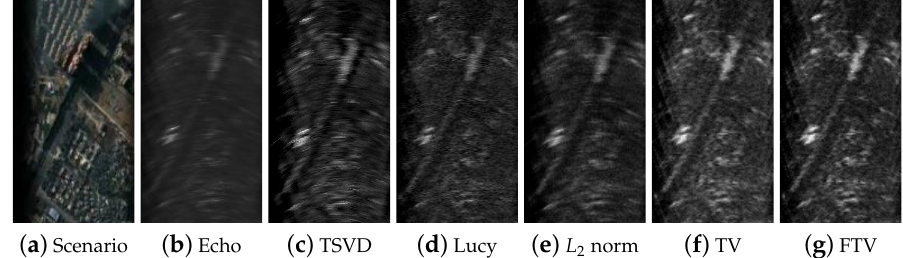
Figure 8. Partially enlarged results for houses. ( a ) Optical scenario; ( b ) Echo image; ( c ) The TSVD method result; ( d ) The Lucy-Richardson method result; ( e ) The L 2 norm regularization method result; ( f ) The TV method result; ( g ) The proposed FTV method result.